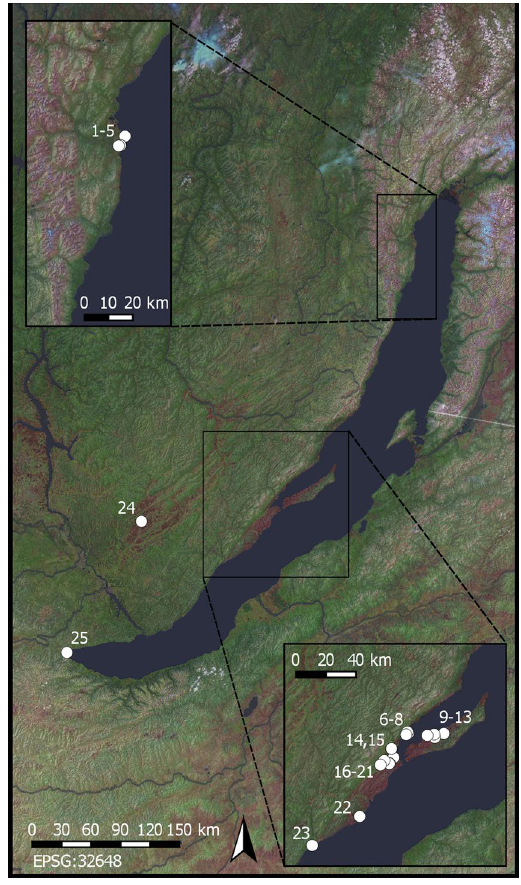
Figure 1. Map of the Lake Baikal region of the Russian Federation: (a) North Baikal; (b) Priol’khon’e. Archaeological sites analyzed in the study indicated: 1) Relka 1; 2) Baikal’skoe 7; 3) Baikal’skoe 27; 4) Baikal’skoe 31; 5) Krasnyi Iar; 6) Kurma 2; 7) Khadarta 2; 8) Tsagan-Nuge 2; 9) Khuzhirtui 1; 10) Elga 21; 11) Elga 7; 12) Khuzhir 2; 13) Khuzhir 4; 14) Khuzhir-Nuge 18; 15) Khuzhir Nuge 3; 16) Olzontei 16; 17) Kargarnai 1; 18) Olzontei 6; 19) Shara-Tagot; 20) Kurkut 4; 21) Olzontei 8; 22) Sagan-Zaba 2; 23) Bugul’deika 2; 24) Mankhai 3; 25) Shamanka 2. Landsat data courtesy of the U.S. Geological Survey. Landsat image tiles, which are open access files, were acquired through QGIS QuickMapServices 62